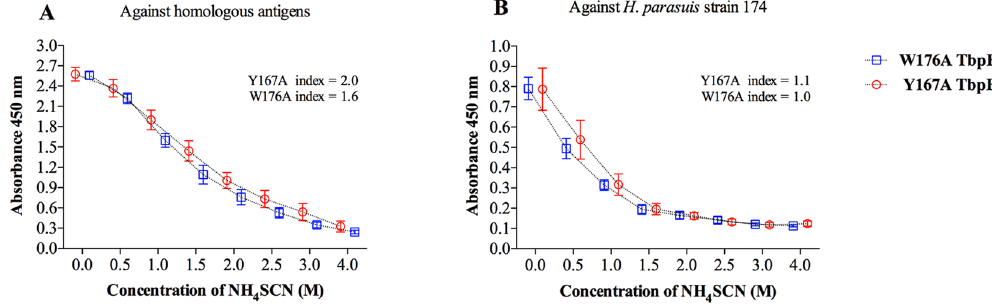
Figure 7. Avidity curves of polyclonal pig antibodies. The antibody binding force was measured by a thiocyanate elution assay. The avidity index is equal to the concentration of NH 4 SCN that gave 50% reduction in absorbance.